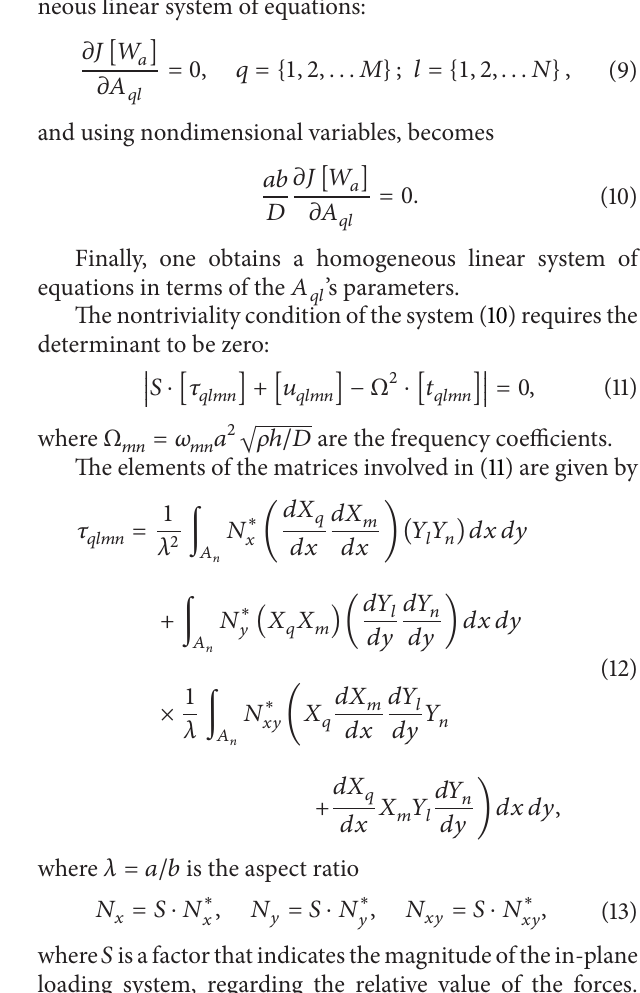
Table 1: The first six natural frequency coefficients Ω 𝑖 for a C-C-F-F plate under general in-plane loading.